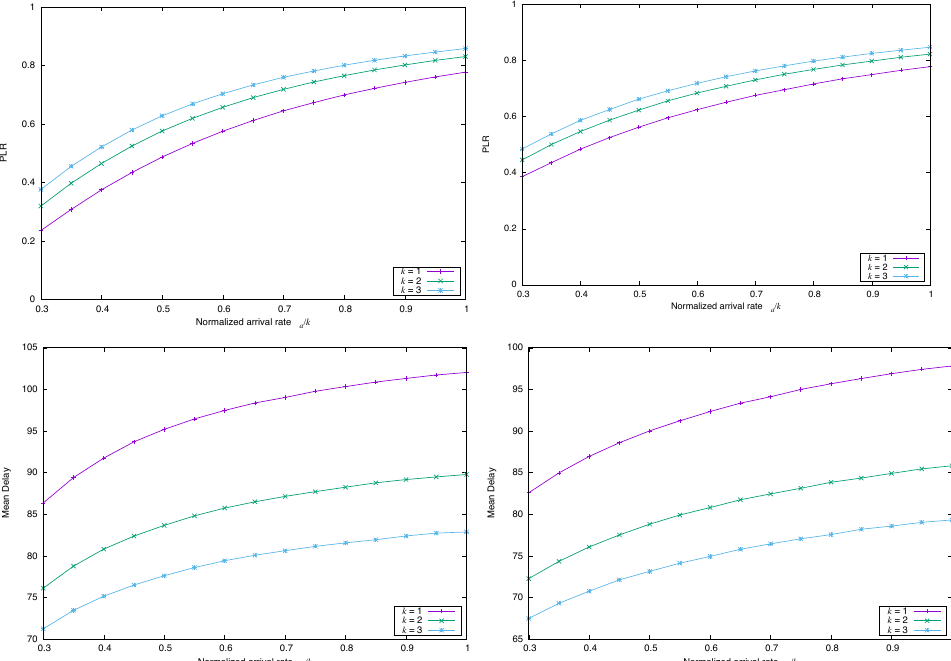
Figure 7. Simulated PLR ( top ) and Mean Delay ( bottom ) for FS-CSA versus λ a / k , with Λ ( x ) = 0.86 x 3 + 0.14 x 8 , n = 200 and k = { 1,2,3 } , and marginal distribution Pareto, with σ 2 = 1.1 µ 2 ( left ) and σ 2 = 4 µ 2 ( right